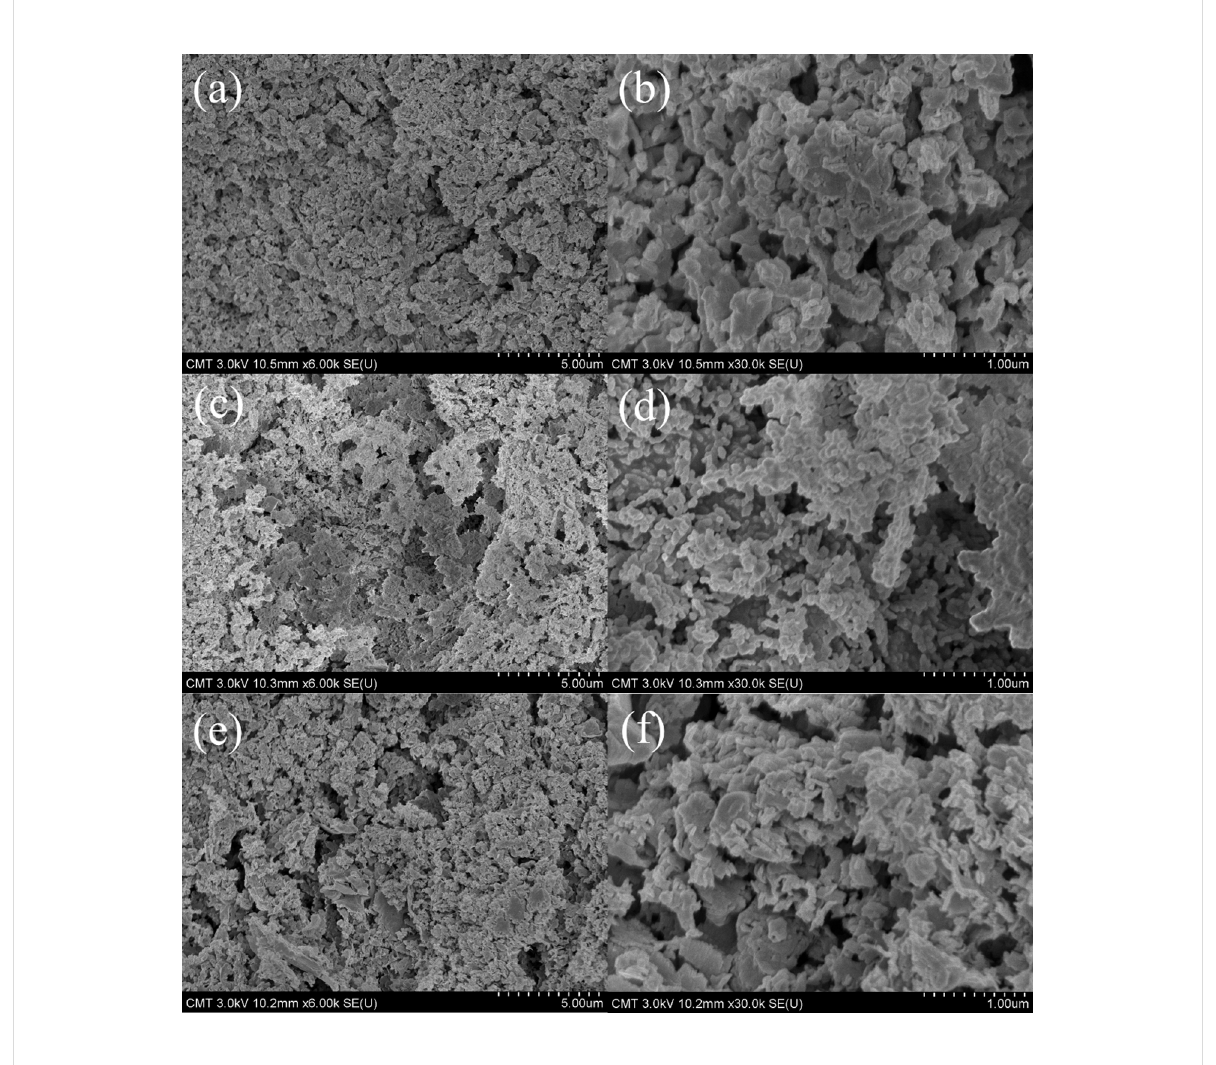
Figure 5: SEM images of (a, b) 3%MgO@g-C 3 N 4 , (c, d) MgO, and (e, f) g-C 3 N 4